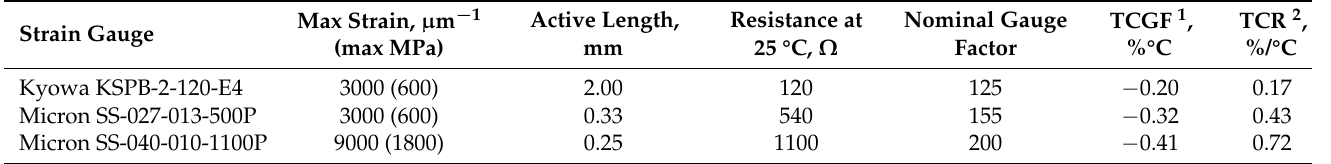
Table 1. Nominal properties of the semiconductor strain gauges used on the CoBL (Kyowa) and MaCE (Micron) pressure